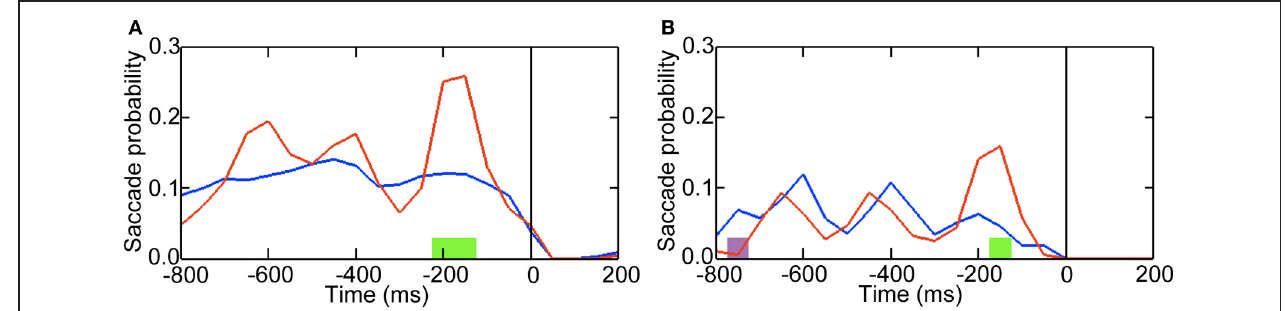
directions were consistent with the preferred interpretation of the Necker cube after the switch. Blue denotes the probabilities of the pre-blink saccades whose directions were inconsistent with the preferred interpretation. Green denotes periods that exhibited increased probabilities of the pre-blink saccades whose directions were consistent with the preferred interpretation ( P < 0 . 05). Purple denotes periods that exhibited increased probabilities of the pre-blink saccades whose directions were inconsistent with the preferred interpretation ( P < 0 .